Question: What form of chart is displayed?
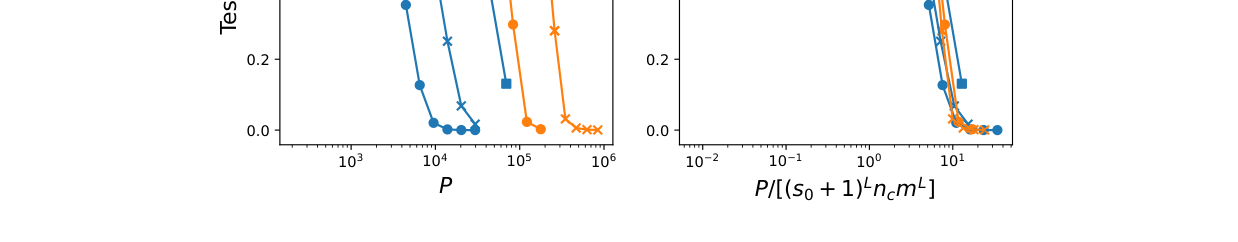
Answer: line